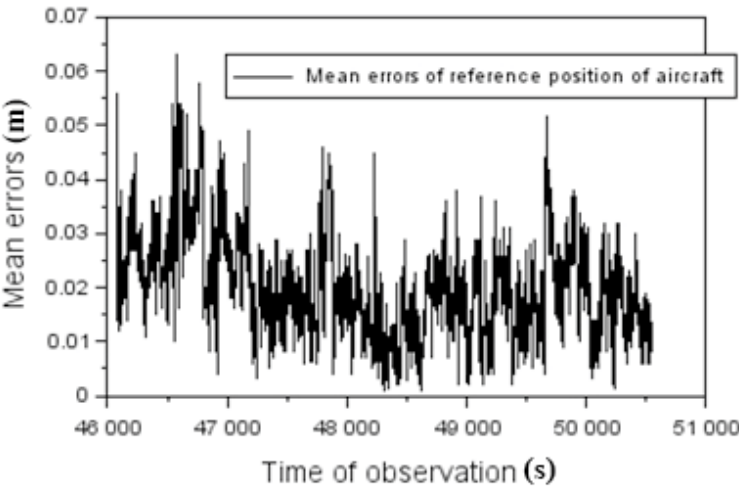
Figure 2. Mean errors of aircraft position from the RTK-OTF solution.